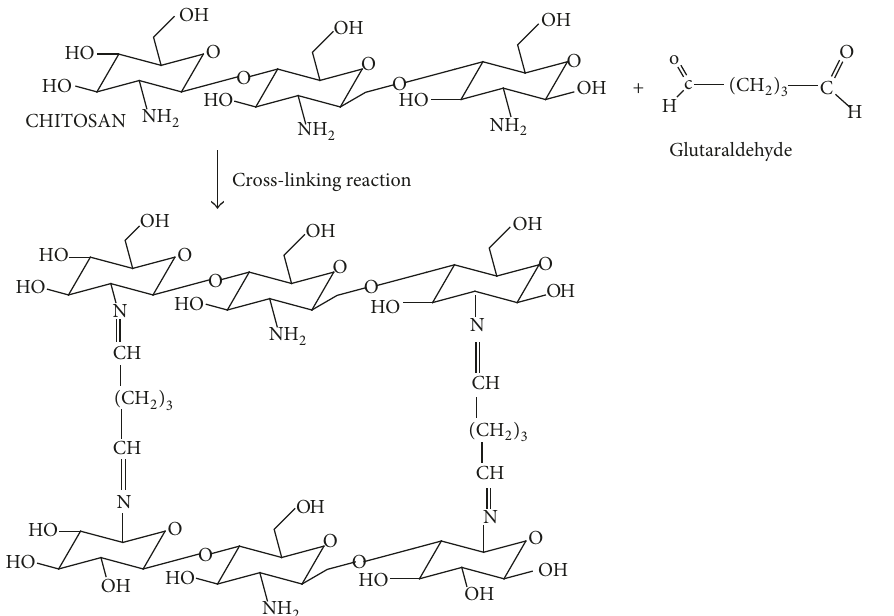
Figure 1: Schematic representation of the cross-linking process of